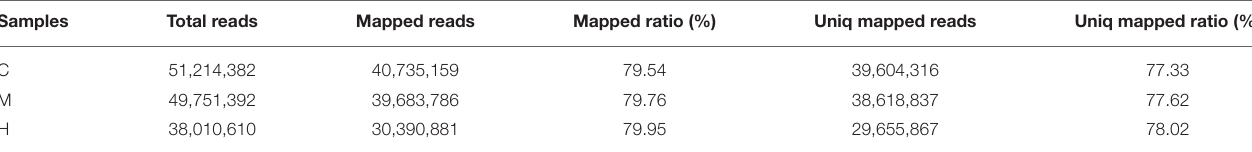
TABLE 1 | Comparison results between cleaned data and reference genome.